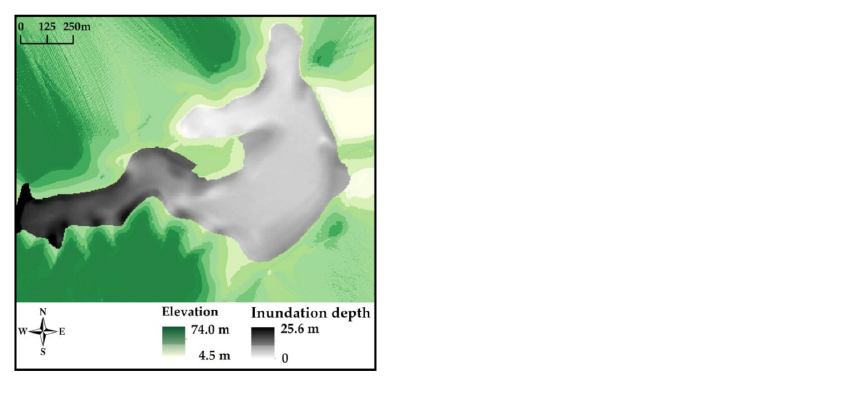
Figure 8. Inundation area and thickness for the process of the Dagangding tailings flow.